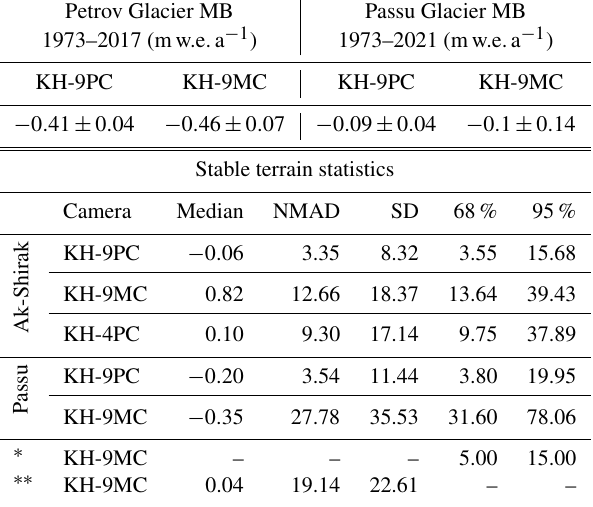
Table 1. Mass balance (MB) of Petrov and Passu glaciers using KH- 9PC and KH-9MC data and dH statistics of stable terrain between the KH-9 and the contemporary DEMs. The dH statistics over stable terrain from Dehecq et al. (2020) ∗ and Zhou et al. (2017) ∗∗ are given for a comparison. SD is the standard